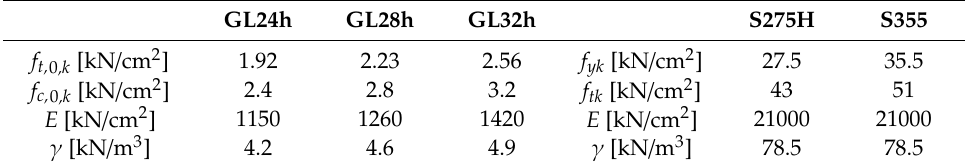
Table 1. Mechanical properties of materials (GL24h, GL28h, GL32h: Glued Laminated Timber grades; f t, 0 ,k : characteristic tension strength parallel the grain; f c, 0, k : characteristic compression strength parallel the grain; S275H: Steel Grade according to UNI EN 10210-1; S355: Steel Grade according to UNI EN